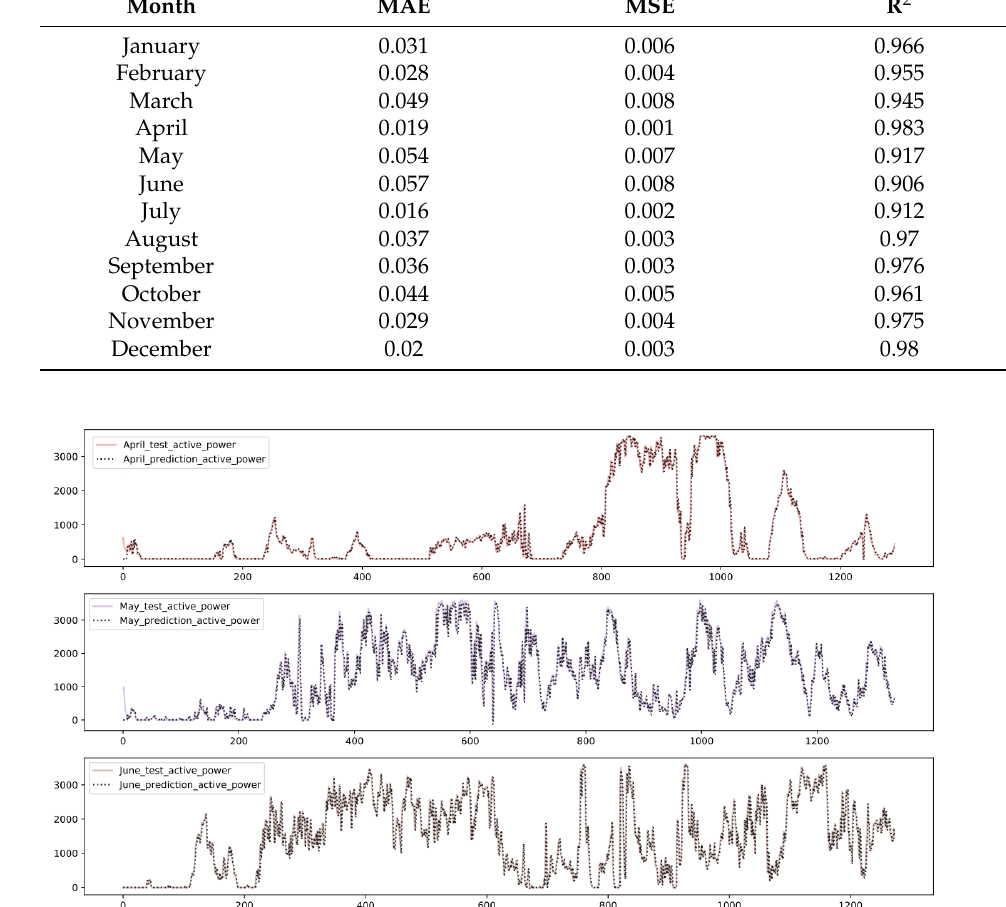
Figure 18. The active power predictions for the test set of April, May, and June.